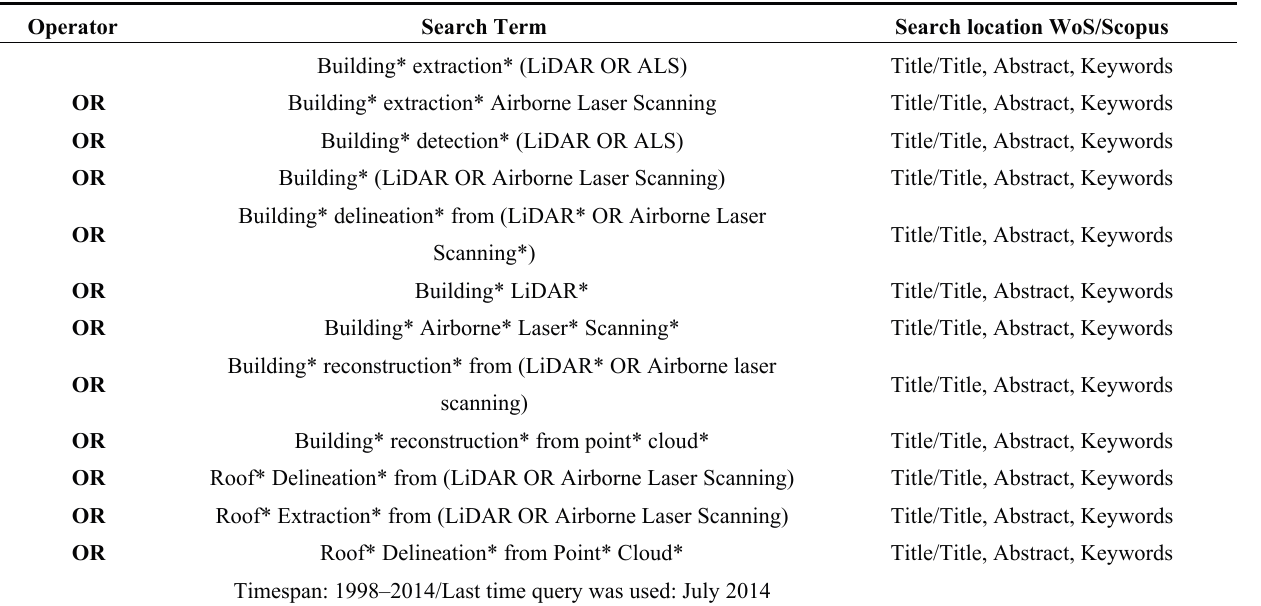
Table 1. Search term used within Web of Science (WoS) and